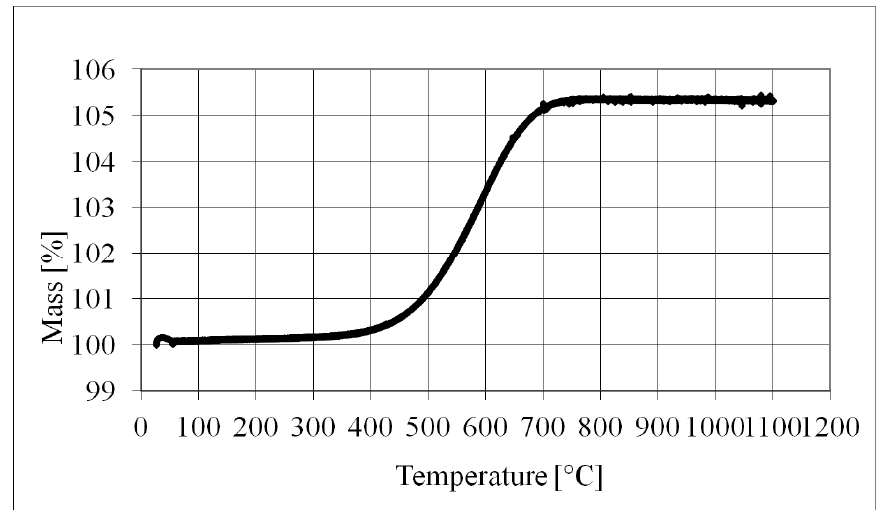
Figure 3. Thermogravimetric analysis of pure Inco 255 nickel powder in